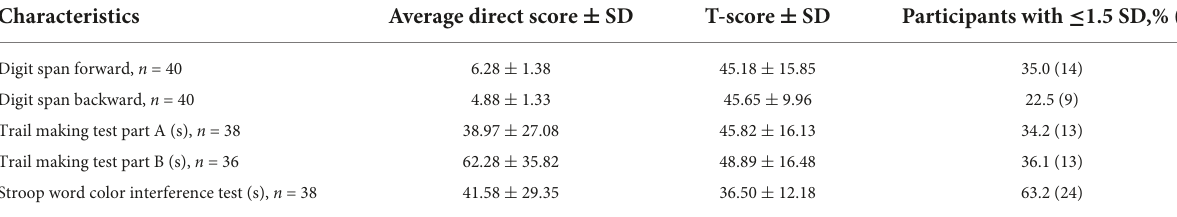
TABLE 3 Computerized neurocognitive test scores in the patients with subacute